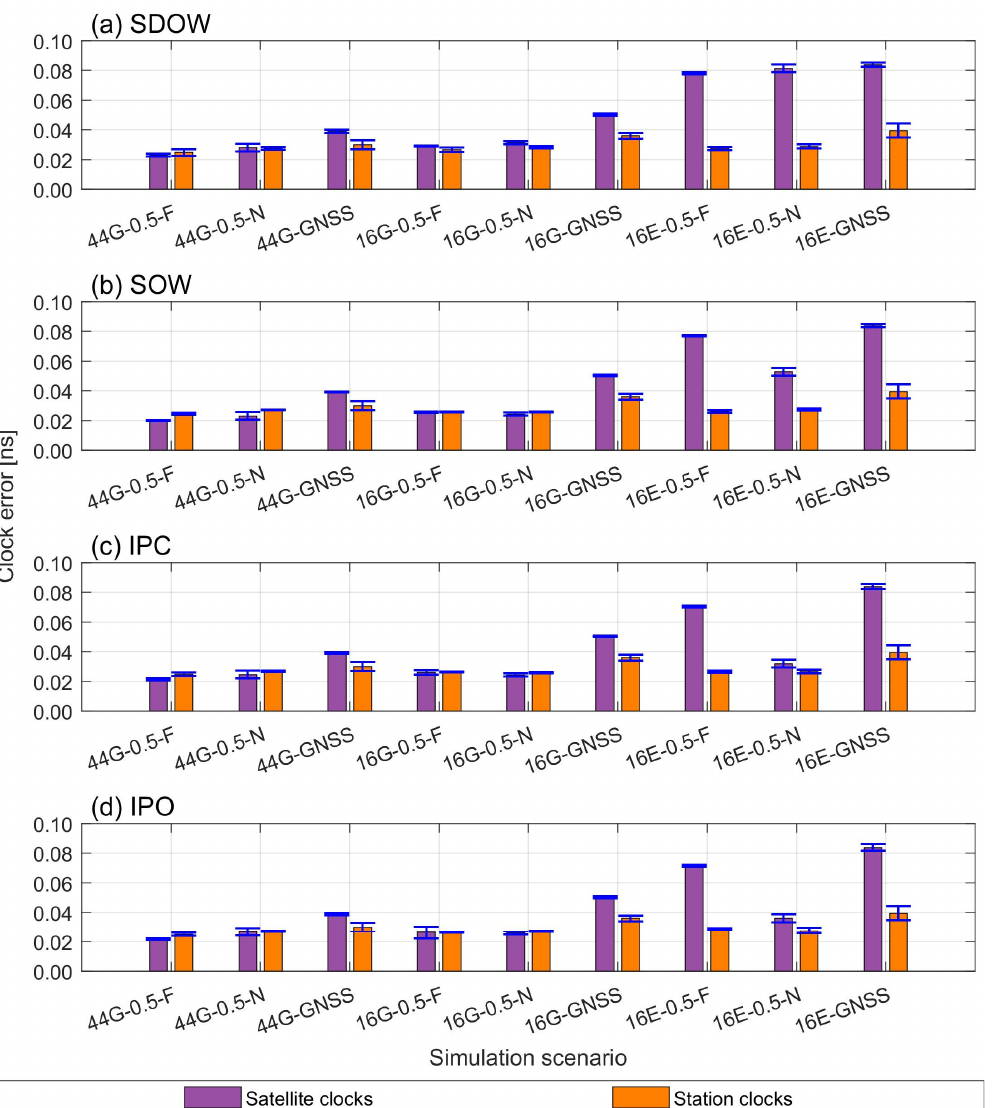
Figure 8. Mean RMS estimation errors for satellite and station clocks considering the station set and VCE approach with respect to connectivity schemes: ( a ) sequential dial one-way (SDOW), ( b ) sequential one-way (SOW), ( c ) intra-plane closed (IPC), and ( d ) intra-plane open (IPO). The simulation scenario names are given in Table 7.